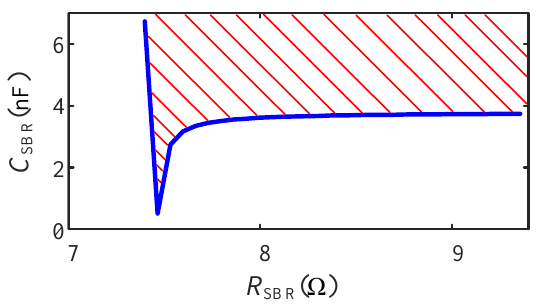
Figure 8. The parametric graph of snubber with the region where oscillation is suppressed.